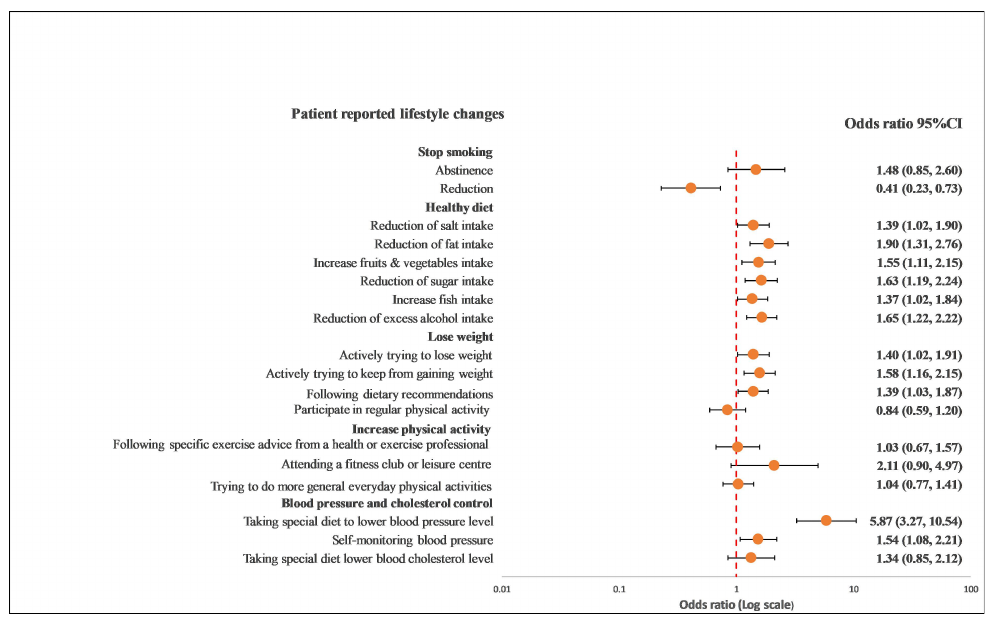
Figure 2. Multivariable logistics regression analysis between the recollection of risk factors and patients’ reported lifestyle changes. The model included the recollection of risk factor information (PRRFI = 0 and GRRFI = 1) as the independent variable, patients’ reported lifestyle changes (no = 0 and yes = 1) as the dependent variables, and age at the index event (continuous), gender, the index event, and obesity, as well as diabetes at hospitalization, as the covariates. PRRFI: poor recollection of risk factor information; GRRFI: good recollection of risk factor information.